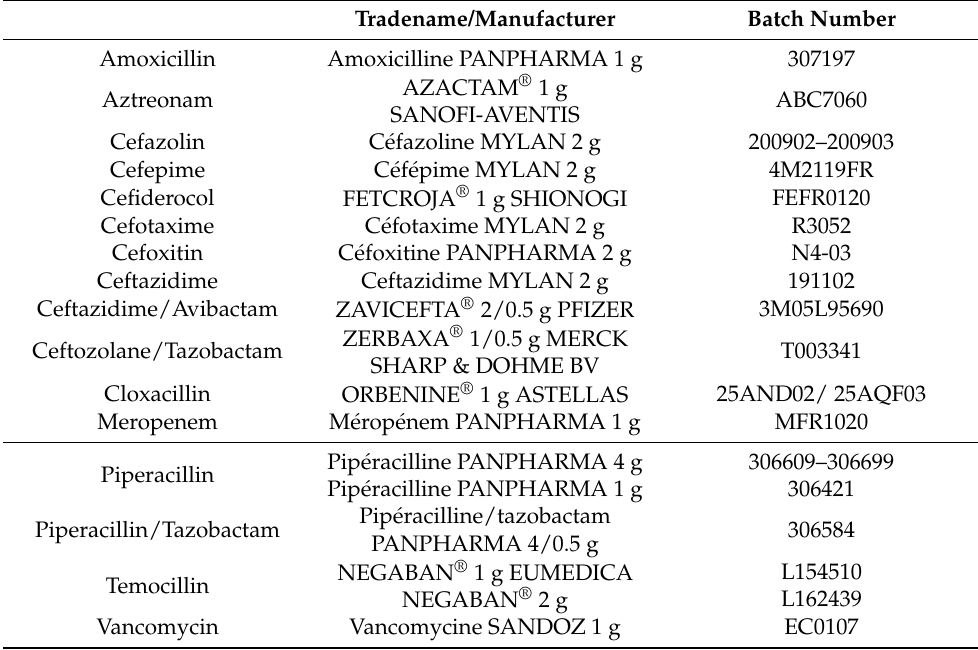
Table 4. List of antibiotics drugs used for the preparation of